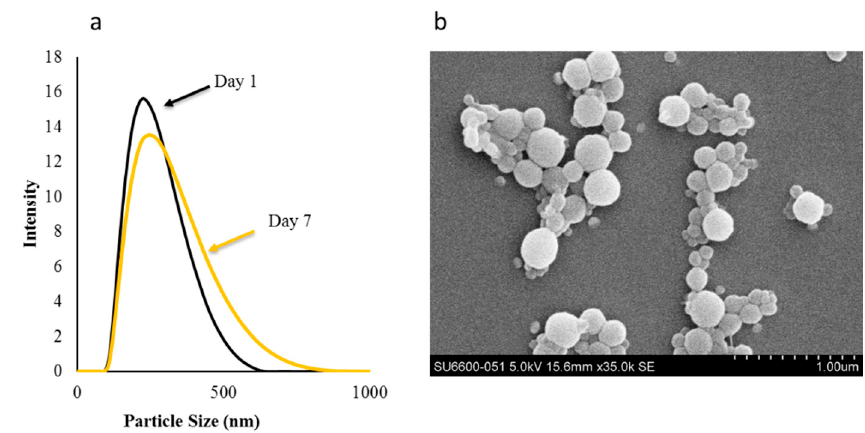
Figure 7. ( a ) Particle size distribution and ( b ) SEM image of the nanoparticles stored at 25 °C for 7 days.